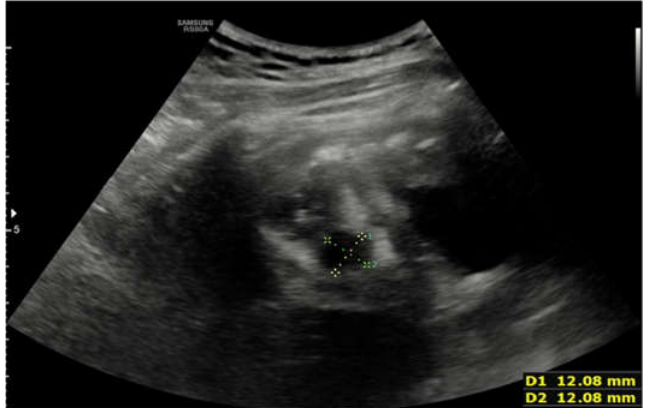
Figure 6. Ultrasound performed on the second day of stay. Another hypoechogenic and inhomoge- neous oval-shaped formations measuring 12 × 12 mm is seen. neous oval-shaped formations measuring 12 × 12 mm is